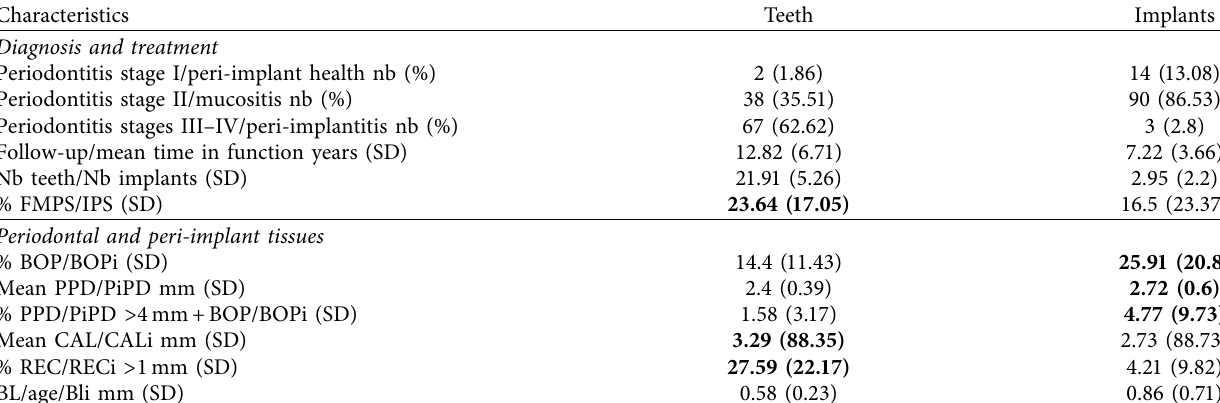
Table 1: Patient periodontal and peri-implant